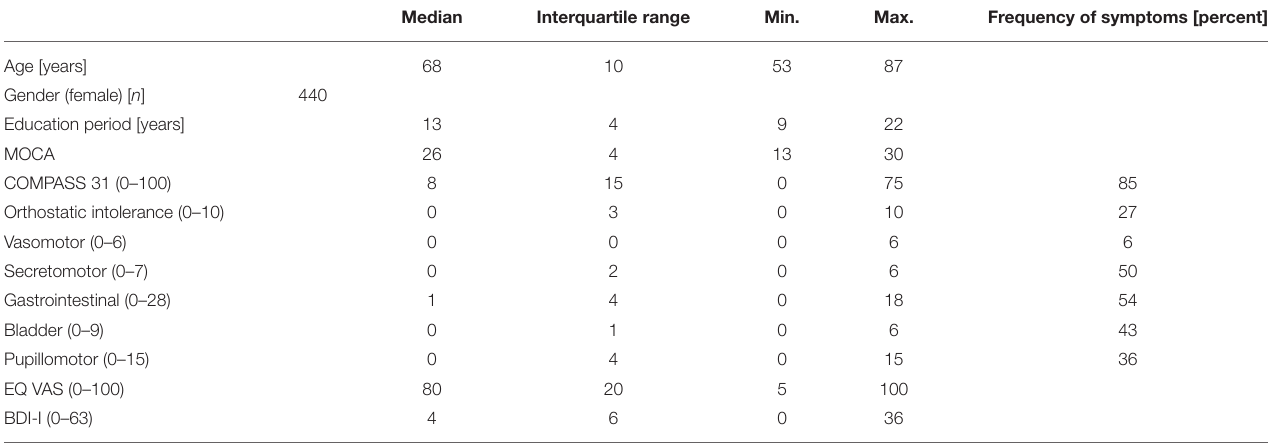
TABLE 1 | Demographic and clinical data. Median Interquartile range Min. Max. Frequency of symptoms